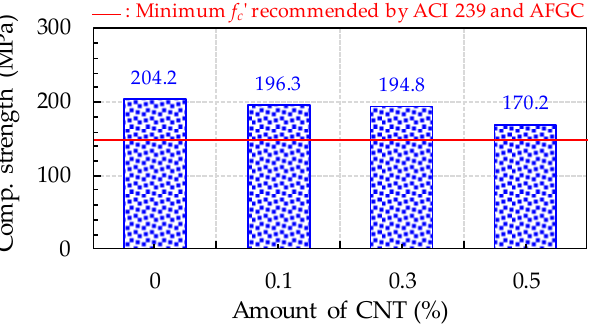
Figure 7. Effect of CNT amount on compressive strength of UHPFRC (Note: f c ’, compressive strength). Scanning electron microscopy (SEM) images for UHPFRC with 0.5 vol % CNTs are shown in